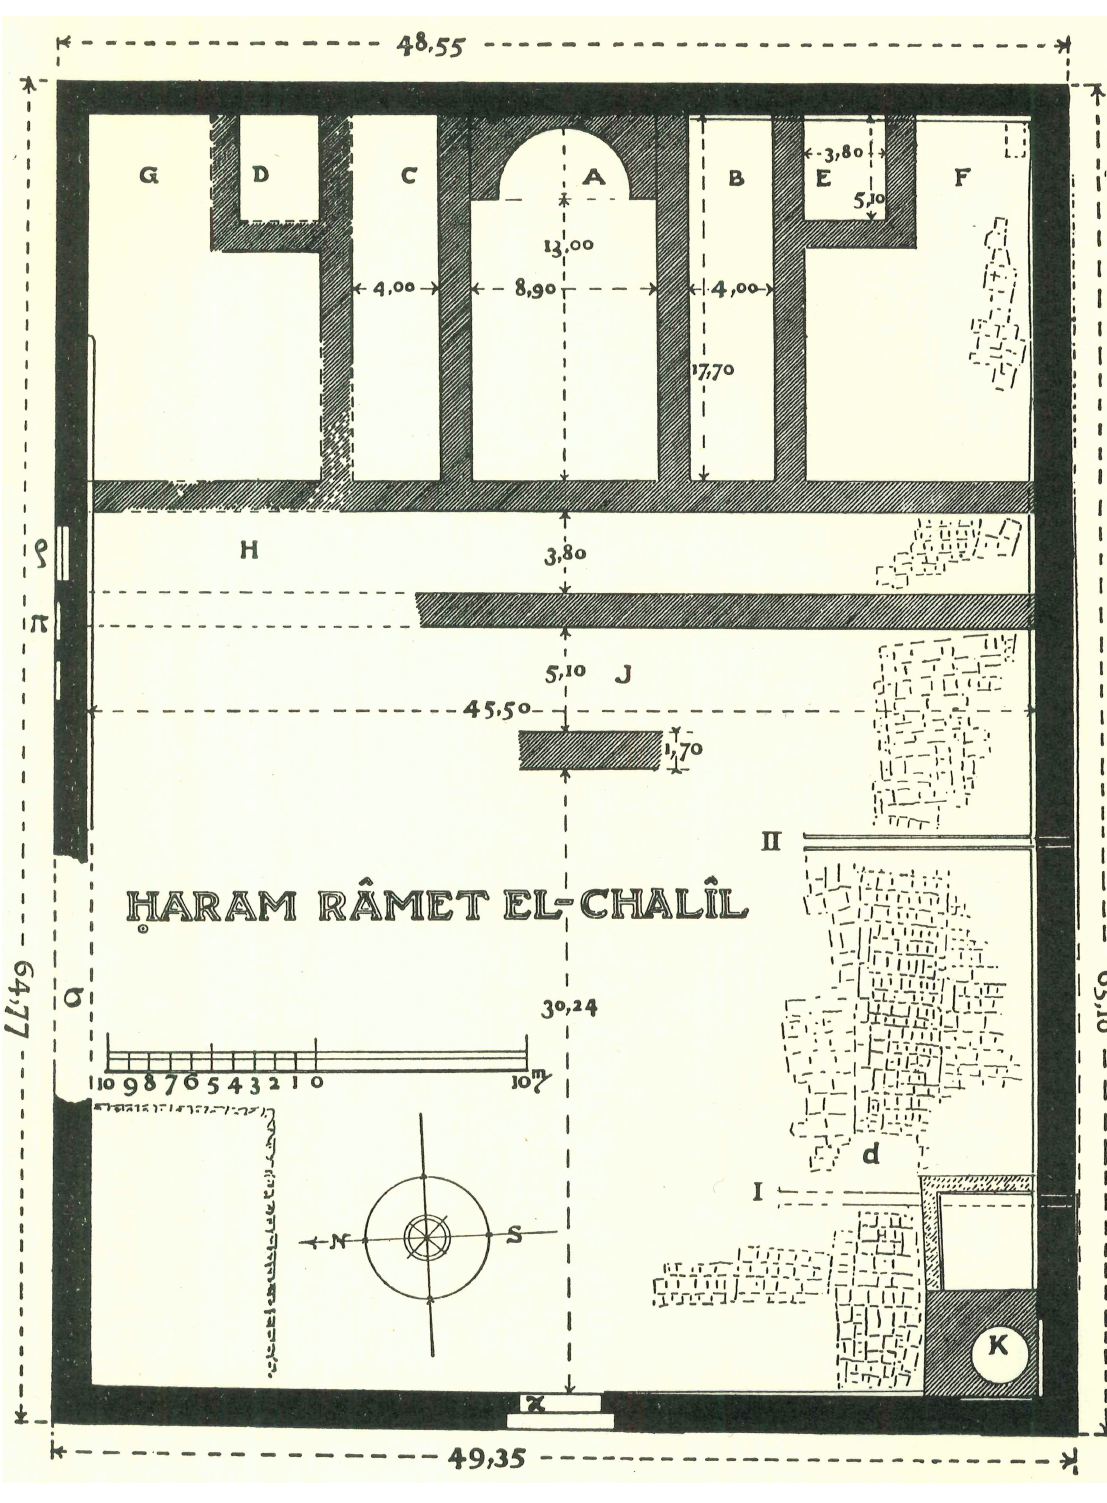
Figure 2 Plan of the enclosure in the fourth century (Mader 1957, sketch 38). Legend: A—Main nave of the Constantinian Basilica, B and C—Side Naves, D-F—Adjoining Rooms (sometimes considered the living rooms of Abraham and Sarah by pilgrims), H—Narthex, J—Altar, K—Well; d—Place of the tree (oak or